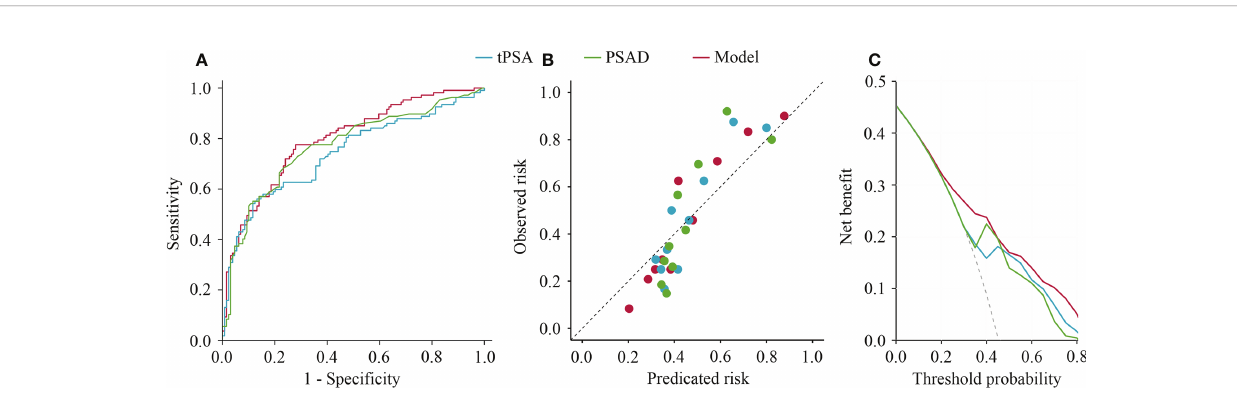
FIGURE 1 | Receiver operating characteristics curves, calibration plot, and decision curve analysis of tPSA, PSAD, and multivariable model for predicting suspicious prostate cancer by mpMRI. (A) Receiver operating characteristics curves; (B) Calibration plot; (C) Decision curve analysis.